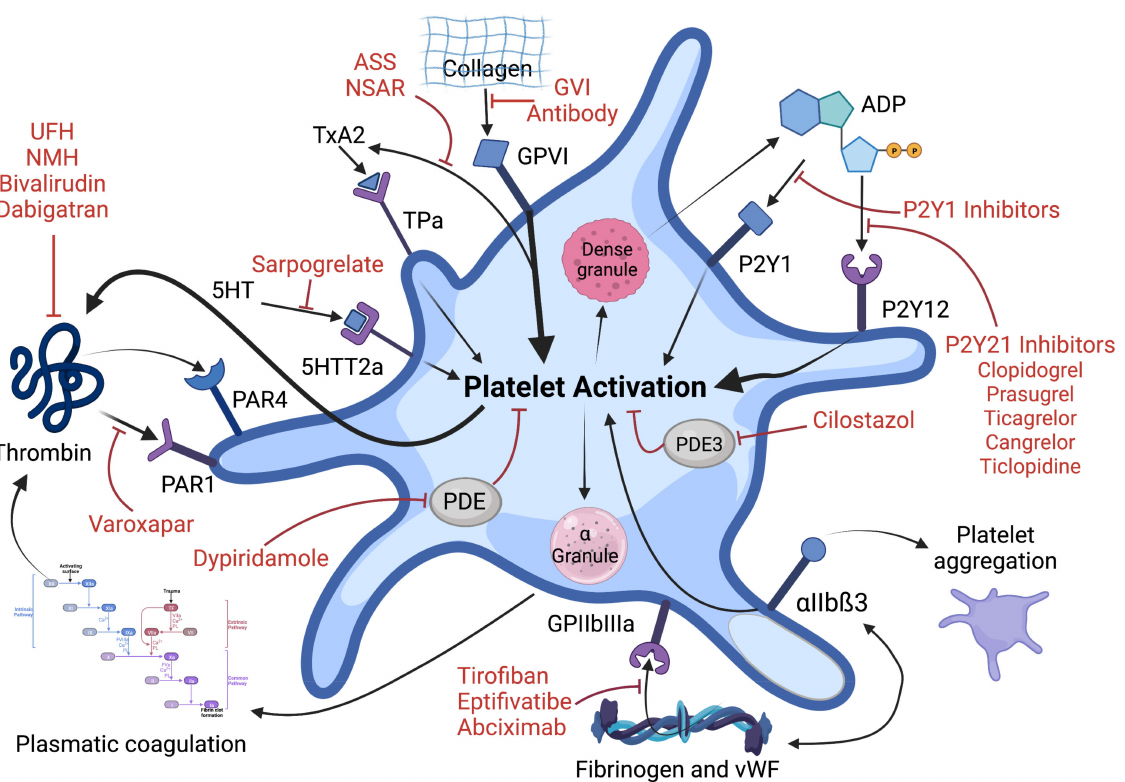
Figure 2. Antiplatelet strategies. Platelet activation pathways and antiplatelet drug strategies. Initial platelet adhesion to damaged vessel walls is mediated by the binding of collagen to platelet GPVI receptor. Thrombin, generated by the coagulation cascade, is also a potent activator of human platelets through PAR1 und PAR4 receptors. P2Y1 and P2Y12 receptors are stimulated by ADP released from dense granules and the thromboxane prostanoid receptor is stimulated by thromboxane generated by COX-1 signaling pathway. Platelet to platelet aggregation is triggered by fibrinogen and von Willebrand factor binding to α IIbß3 receptor. Direct and indirect (via thrombin inhibition) antiplatelet agents and their targets are shown in the figure above